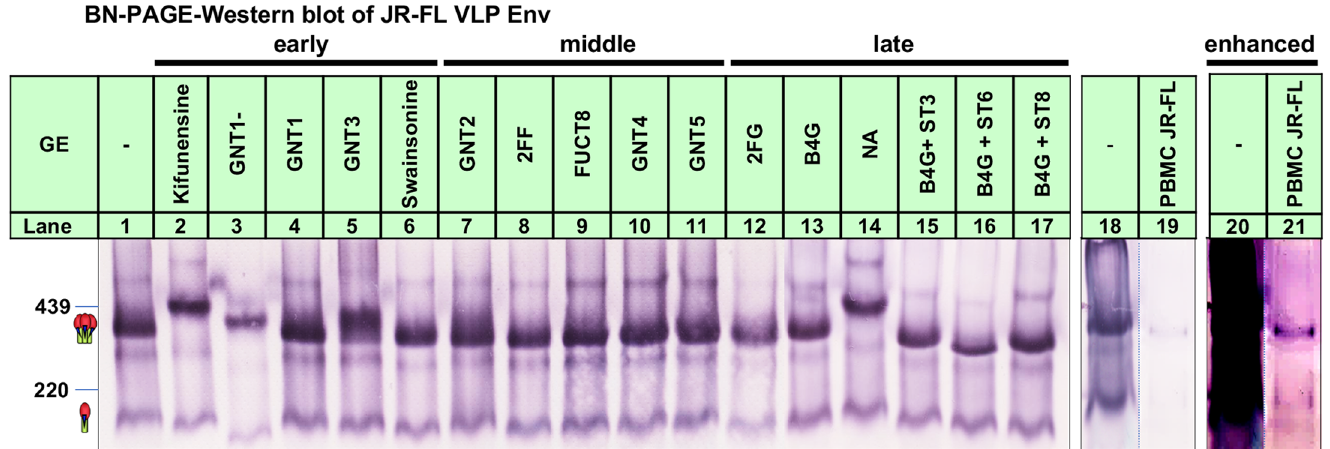
Fig 4. BN-PAGE-Western blot analysis of the effects of GE on particulate Env. Equal volumes (500x concentration) of GE-modified JR-FL SOS E168K gp160 Δ CT VLPs (produced using MuLV Gag and Rev) and human PBMC-propagated replicating JR-FL virus were lysed and analyzed by BN PAGE-Western blot. Env was detected using an anti-HIV primary cocktail (39F, 4E10 and 2F5). Trimer and monomer bands are indicated by cartoons along with ferritin markers. Lanes 20 and 21 are enhanced versions of lanes 18 and 19 to better visualize PBMC Env (lane 21). Abbreviations: B4G = B4GALT1, ST6 = ST6GAL1, ST3 = ST3GAL4, ST8 =